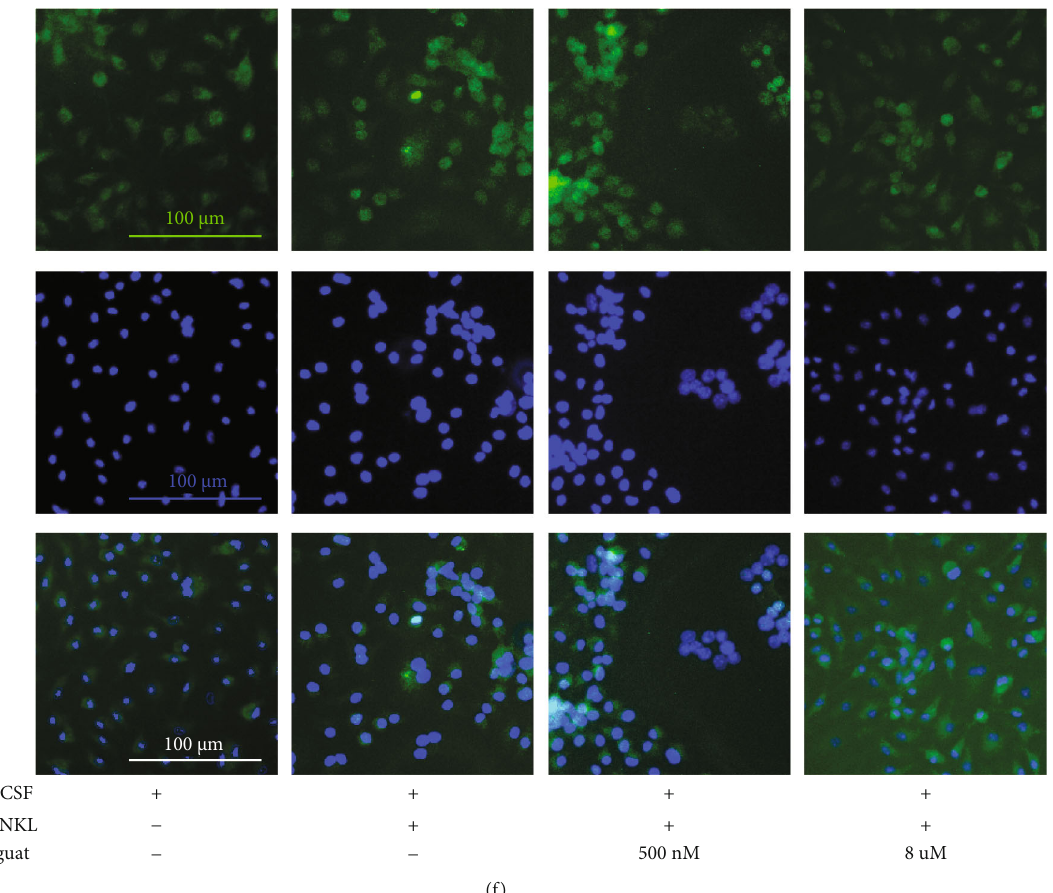
Figure 4: Vericiguat dually regulated RANKL-triggered osteoclast-speci fi c gene expression in osteoclast formation. (a) The relative mRNA expression of osteoclast marker genes (c-Fos, NFATc1, TRAP, CTSK, CTR, and DC-STAMP) in BMMs treated with RANKL+MCSF, as well as indicated concentrations of Vericiguat, for three days was quanti fi ed by qRT-PCR ( n = 3 ). Values are presented as the mean ± standard deviation . ∗ indicated a comparison with the control group (Vericiguat, 0 nM): ∗ p < 0 : 05 , ∗∗ p < 0 : 01 , ∗∗∗ p < 0 : 001 , and ∗∗∗ ∗ p < 0 : 0001 . (b, c) Western blot analysis results on the protein expression levels of OC-related markers including c-Fos and NFATc1 in BMM cells stimulated with RANKL for 5 d without or with Vericiguat with indicated concentrations and quantitative results ( n = 3 ). ∗ indicated a comparison with the control group (Vericiguat, 0nM): ∗ p < 0 : 05 , ∗∗ p < 0 : 01 , ∗∗∗ p < 0 : 001 , and ∗∗∗∗ p < 0 : 0001 . (d, e) The cytoplasmic and nuclear fractions of the BMMs treated with 30 ng/mL M-CSF, 50 ng/mL RANKL, and Vericiguat (500nM and 8 μ M) for 0, 2, and 4 d, respectively, were analyzed by western blotting and quantitative results. GAPDH and histone H3 were used as nuclear and cytoplasmic loading controls, respectively ( n = 3 ). ∗ indicated a comparison with the control group (Vericiguat, 0nM) regarding the protein expression of NFATc1 within the cytosol at day 4 after stimulation: ∗∗∗ p < 0 : 001 and ∗∗∗∗ p < 0 : 0001 . # indicated a comparison with the control group (Vericiguat, 0nM) regarding the protein expression of NFATc1 within the nucleus at day 4 after stimulation: #### p < 0 : 0001 . (f) Immuno fl uorescence results of the nuclear translocation of NFATc1 at day 4 after stimulation showed that Vericiguat at low concentration promoted the nuclear translocation of NFATc1, whereas high-concentration Vericiguat suppressed this e ff ect. ns: not statistically signi fi cant. Scale bar = 100 μ m